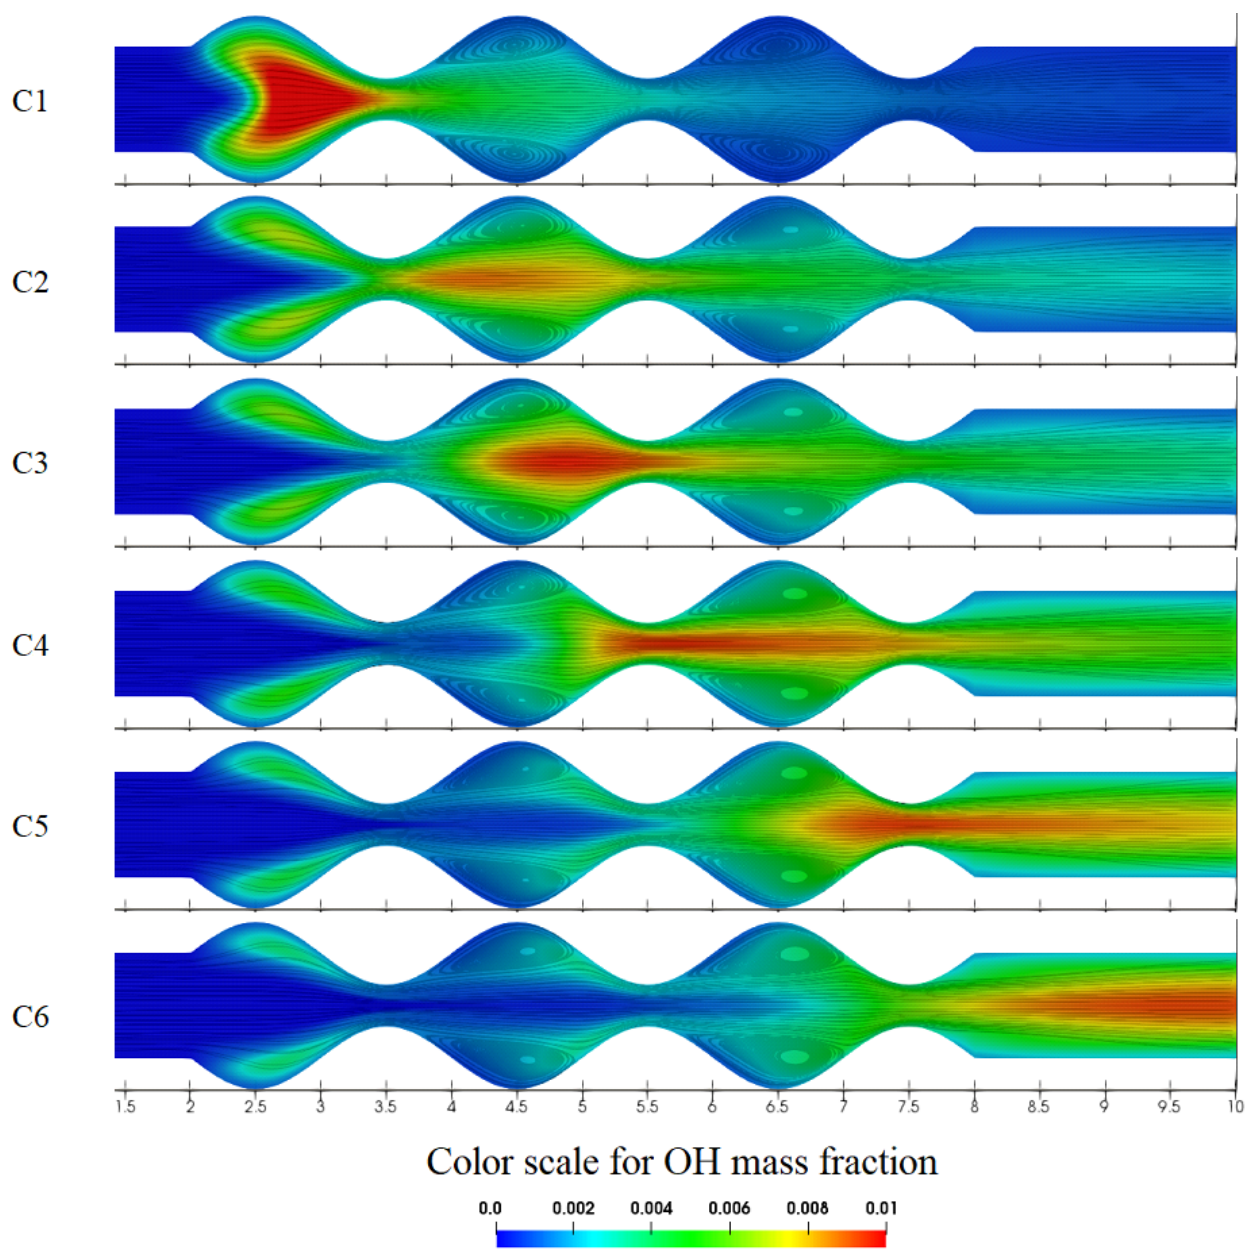
Figure 6. Contour maps for the streamlines superimposed on OH mass fraction distribution for different